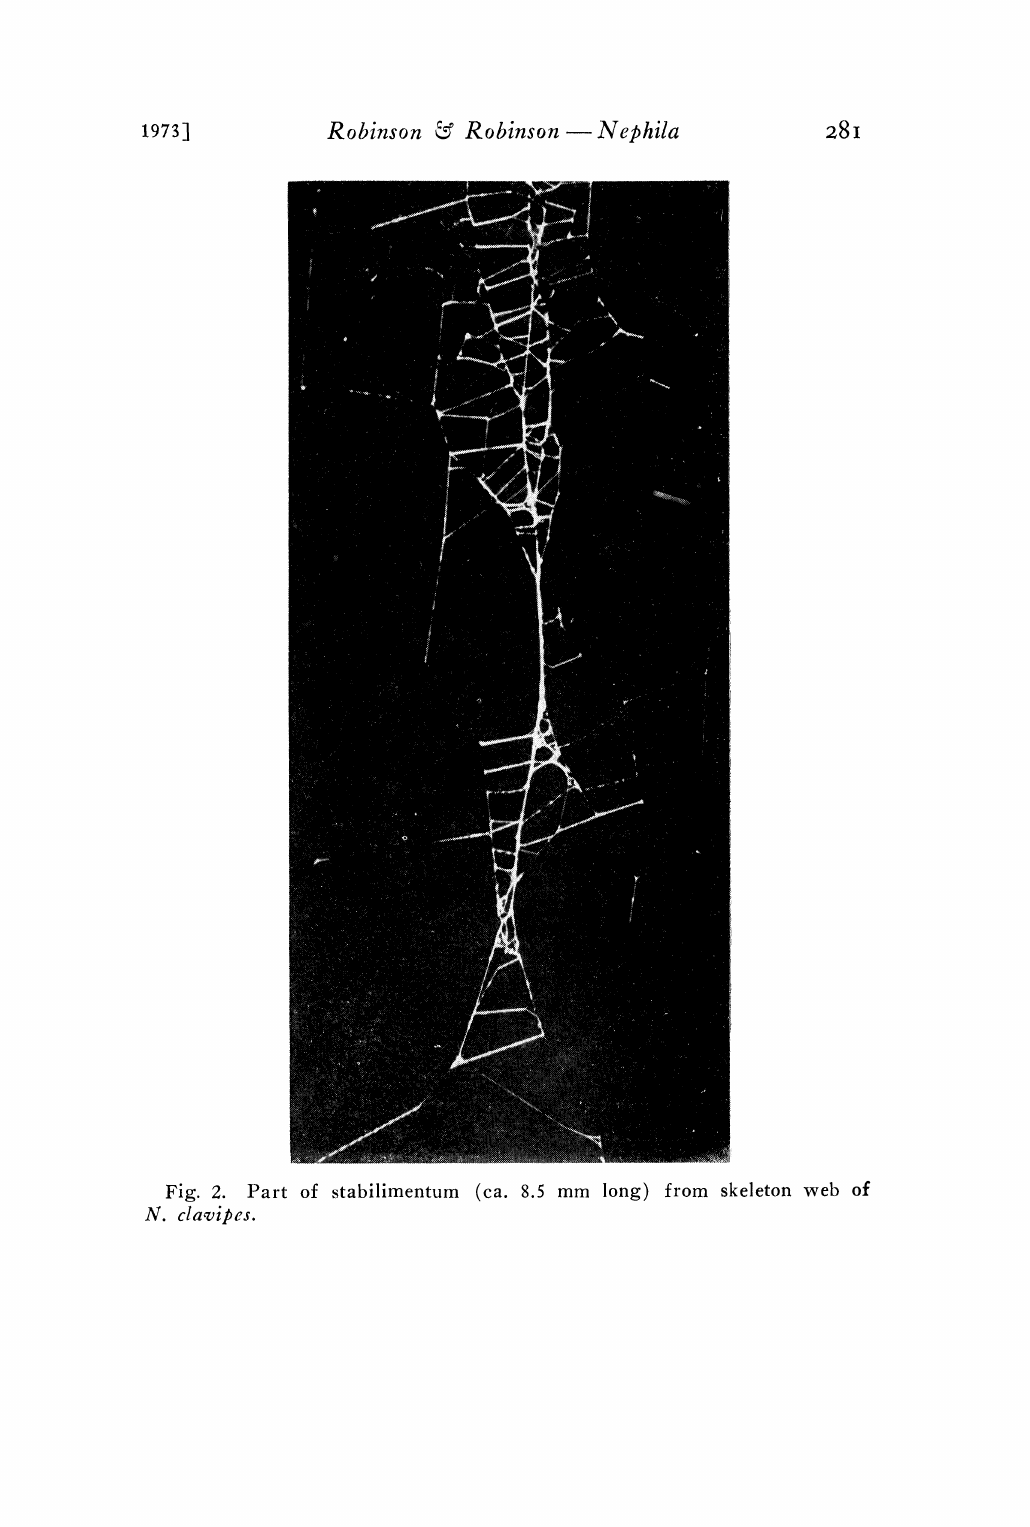
Fig. 2. Part of stabilimentum (ca. 8.5 mm long) from skeleton web of N.